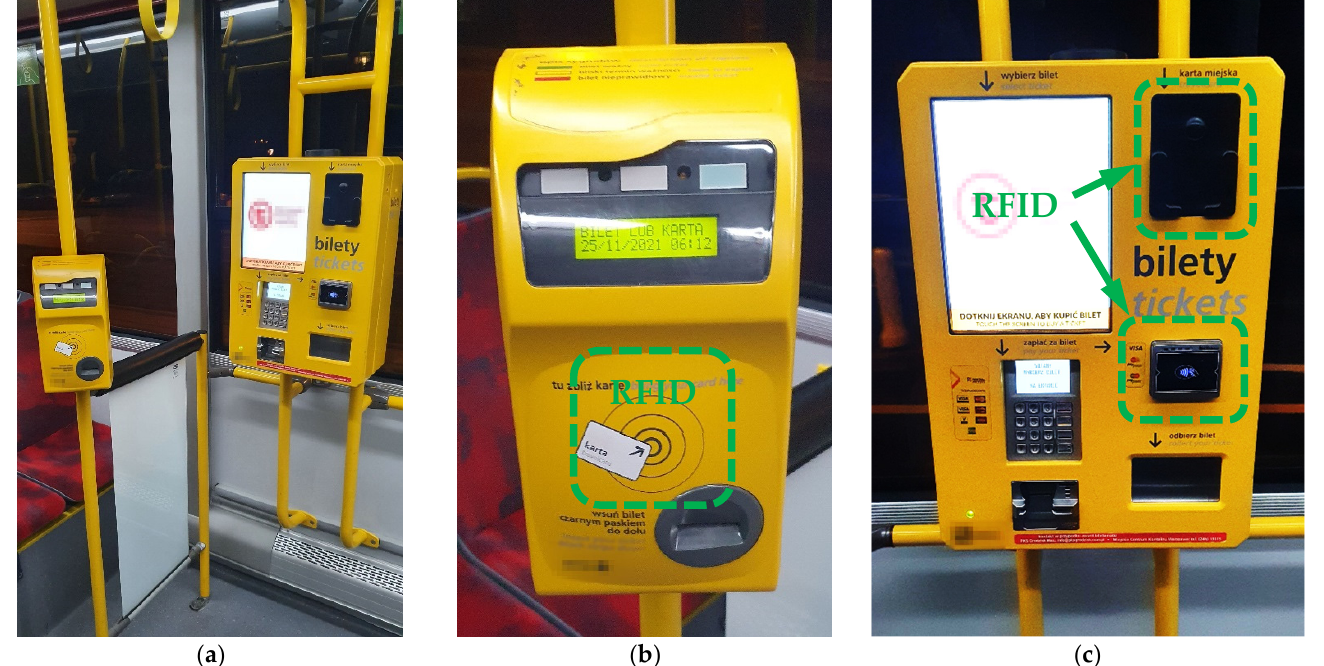
Figure 1. Examples of HF RFID readers used in public transport vehicles: ( a ) “ticket area” inside the central space of the bus; ( b ) ticket and contactless public transport card validator; ( c ) ticket machine operating the loading of contactless public transport cards using payment by a contactless card or other PICC electronic device (positions of HF RFID readers are marked with a dashed line).